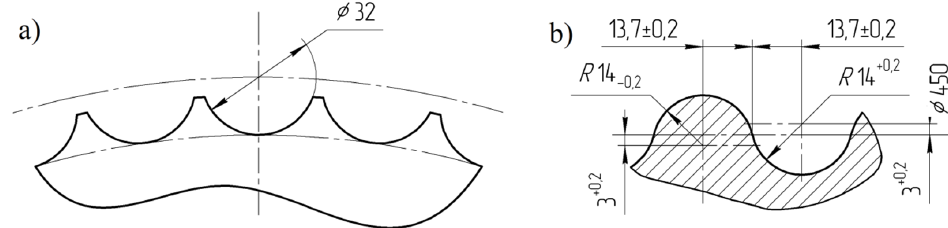
Figure 4. Geometry of molding cavities on the working surface of rolls used for tests: ( a ) front view and ( b ) cross section through the groove [69].